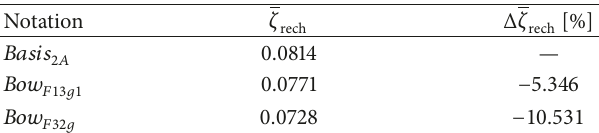
Table 8: Integrated loss coefficient of the rotor for the calculated